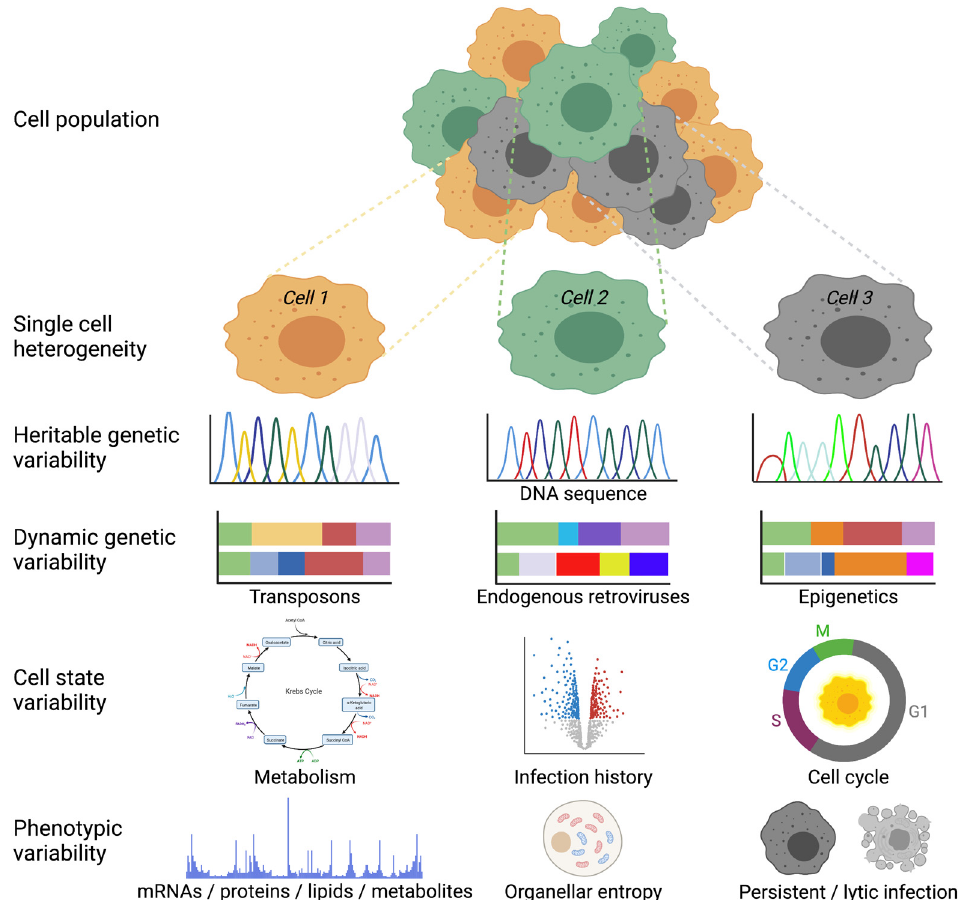
Figure 3. Cell-centric mechanisms underlying virus infection variability. Cells in a given population may be variable at the single-cell level due to at least four principle features: one is heritable genetic variability in the DNA sequence; two is dynamic genetic changes driven by mobile genetic elements or epigenetic differences; three is cell state differences, such as metabolism, infection history, or cell cycle; four is differences in phenotypes, such as macromolecules, organellar positioning with respect to each other (entropy), or the infection state. Figure was prepared by using BioRender.